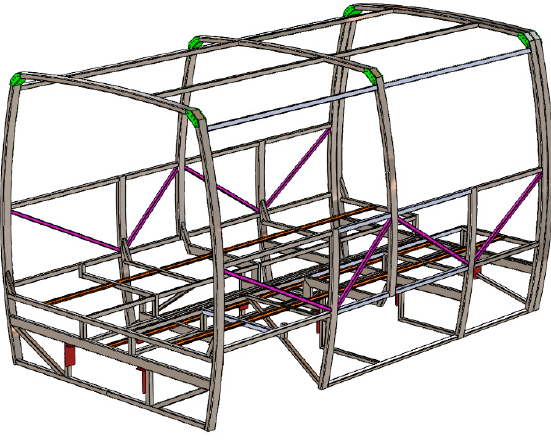
Figure 3. A geometrical model of the safety structure.